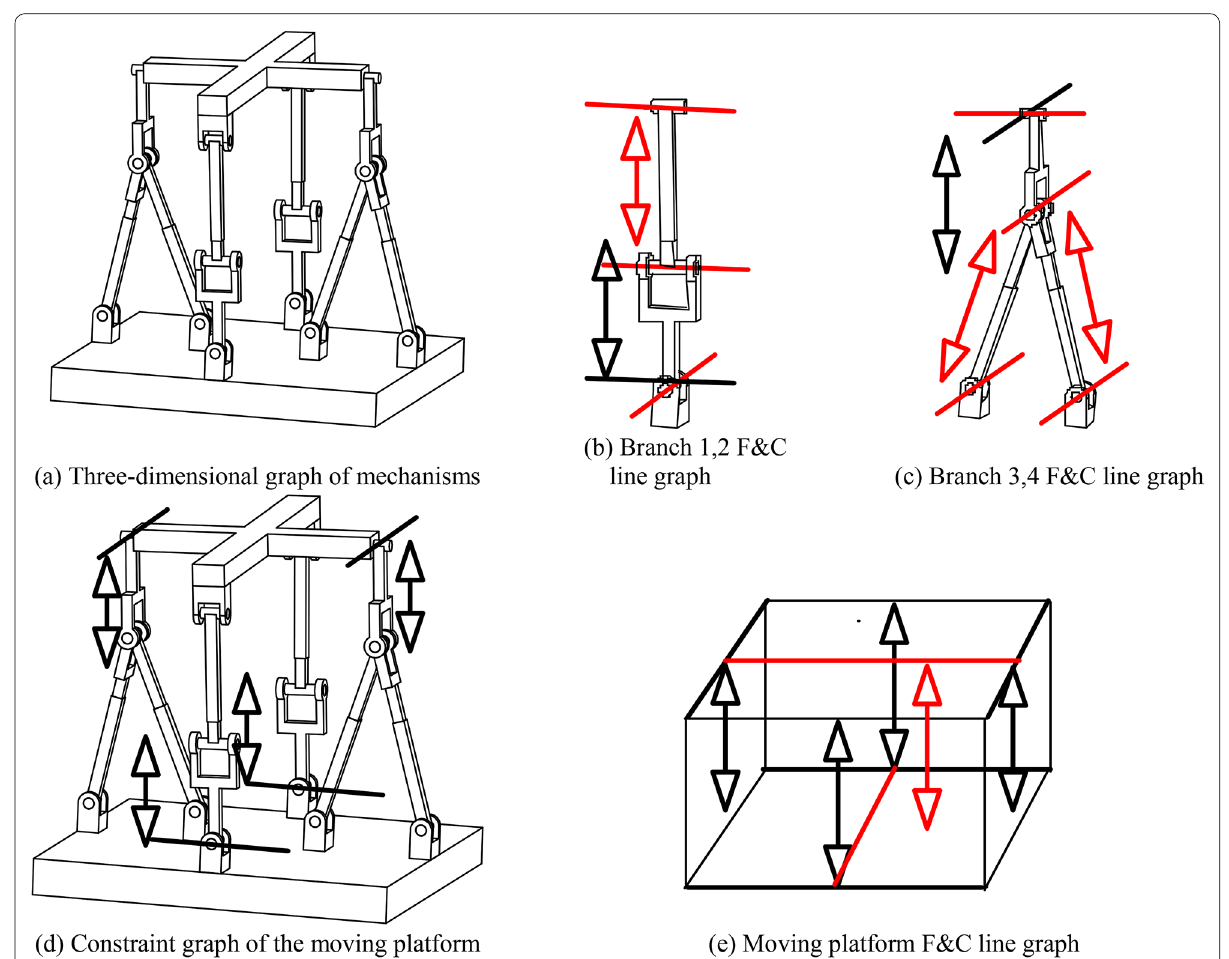
Figure 13 Correlated line diagram at initial